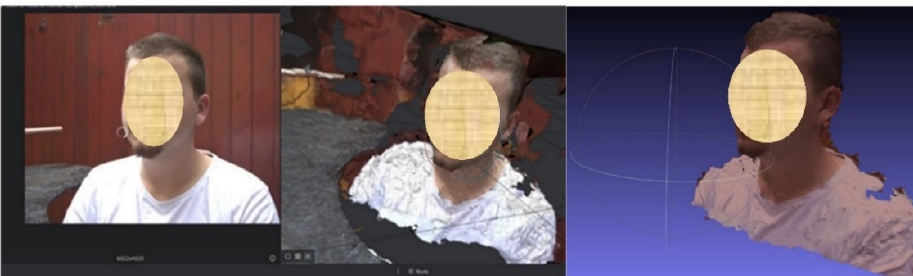
Figure 13. Final frame of the spectacles adapted to the 3D anatomical features of the wearer of the spectacles. Based on the 3D model, a series of spectacles frames have been designed that can be subsequently adjusted to the needs of each client, using the assisted design software. The spectacle frame consists of a lens holder, called the front, the arms for fixing the glasses behind the ear, and the nasal saddle. In the design process, the spectacles frames should be aesthetic, light, resistant to physical and chemical agents, non-flammable, and durable. For the correct assessment of the parameters related to shape and dimensions of the spectacles frames [28], the Boxing system was used, which is mainly used in the USA, Germany, as well as in Romania. After finishing the reconstruction process, the 3D model in Figure 14 was obtained.